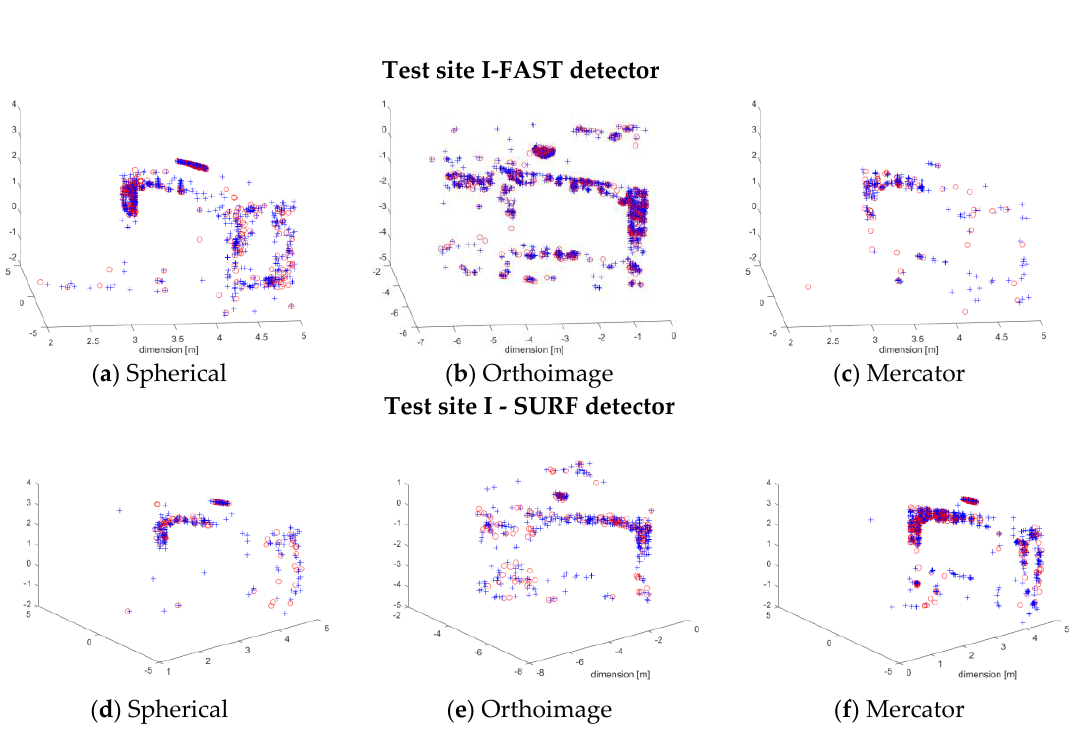
Figure A.1. Distribution of points used in the TLS data orientation process for the pair of scans for the scanner stations for test sites I : “The Queen’s Bedroom” -the best distribution of the control (blue) and check points (red). Points detected by FAST ( a – c ) and SURF ( d – f ) detectors on raster images: ( a/d ) in the spherical projections, ( b/e ) in the orthoimage and ( c/f ) in the Mercator projection.